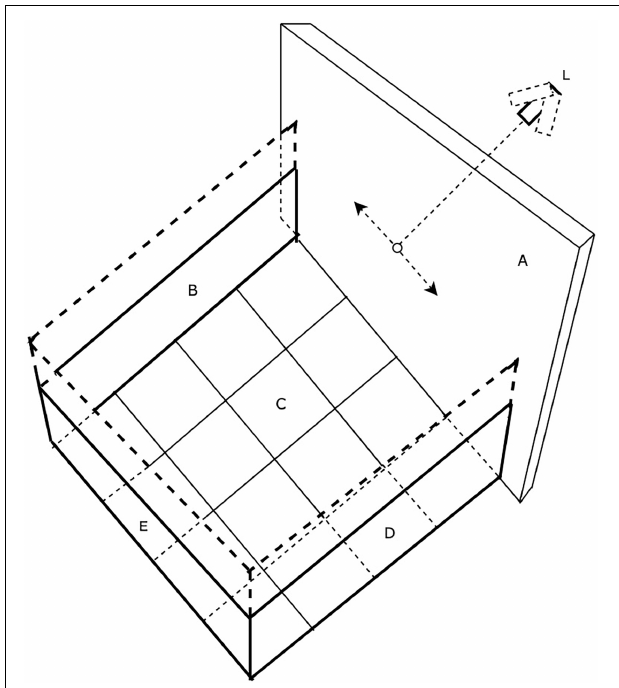
FIGURE 1 | The testing arena. Walls B and C are opaque while wall A is translucent plastic upon which a laser spot could be projected from a laser (L) mounted on a stepping motor and made to move under computer control (L).